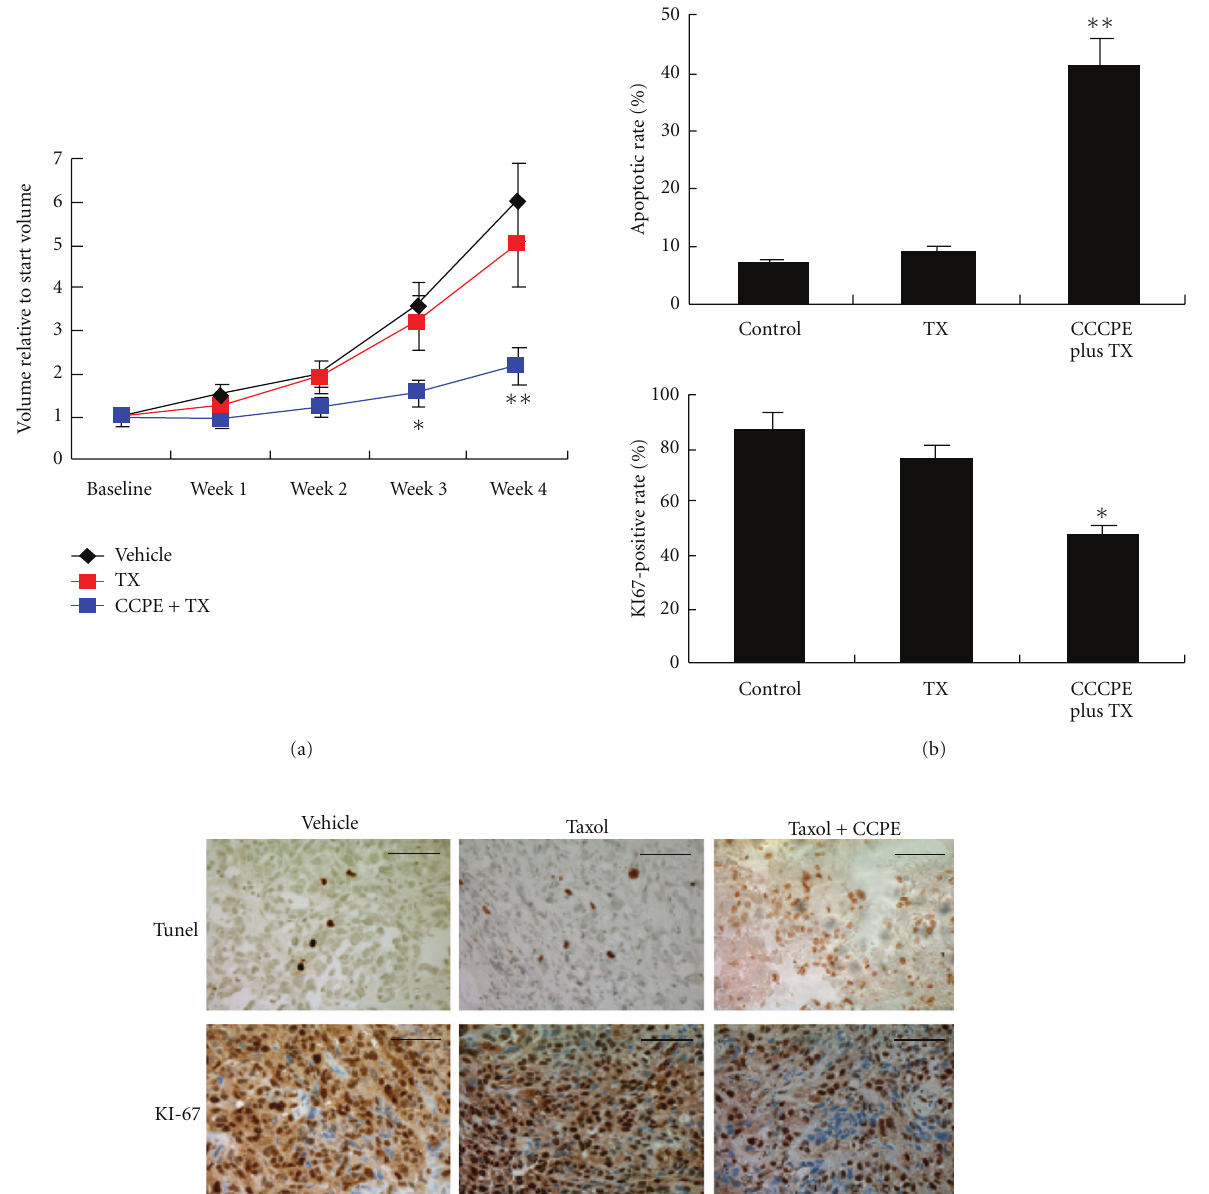
Figure 4: Combination therapy of C-CPE and taxol attenuates EOC xenograft growth in vivo . Female SCID mice were inoculated s.c. with 5 × 10 6 SKOV-3 cells. Four weeks later, the mice harboring large tumor burden were intraperitoneally administered with taxol alone (20mg/kg), taxol combined with C-CPE (0.1mg/kg), or vehicle (PBS) twice a week for 4 weeks. (a) Growth curves of tumors were presented as the mean volume normalized to the start volume. ∗ The combination of C-CPE and taxol led to a significant tumor suppression compared with vehicle or taxol alone ( P < 0 . 05). (b) After 4 weeks of treatment, immunostaining of Ki67 and TUNEL was performed to evaluate cell proliferation and apoptosis in EOC xenografts. ∗ P < 0 . 05; ∗∗ P < 0 . 001. Reproduced with permission from